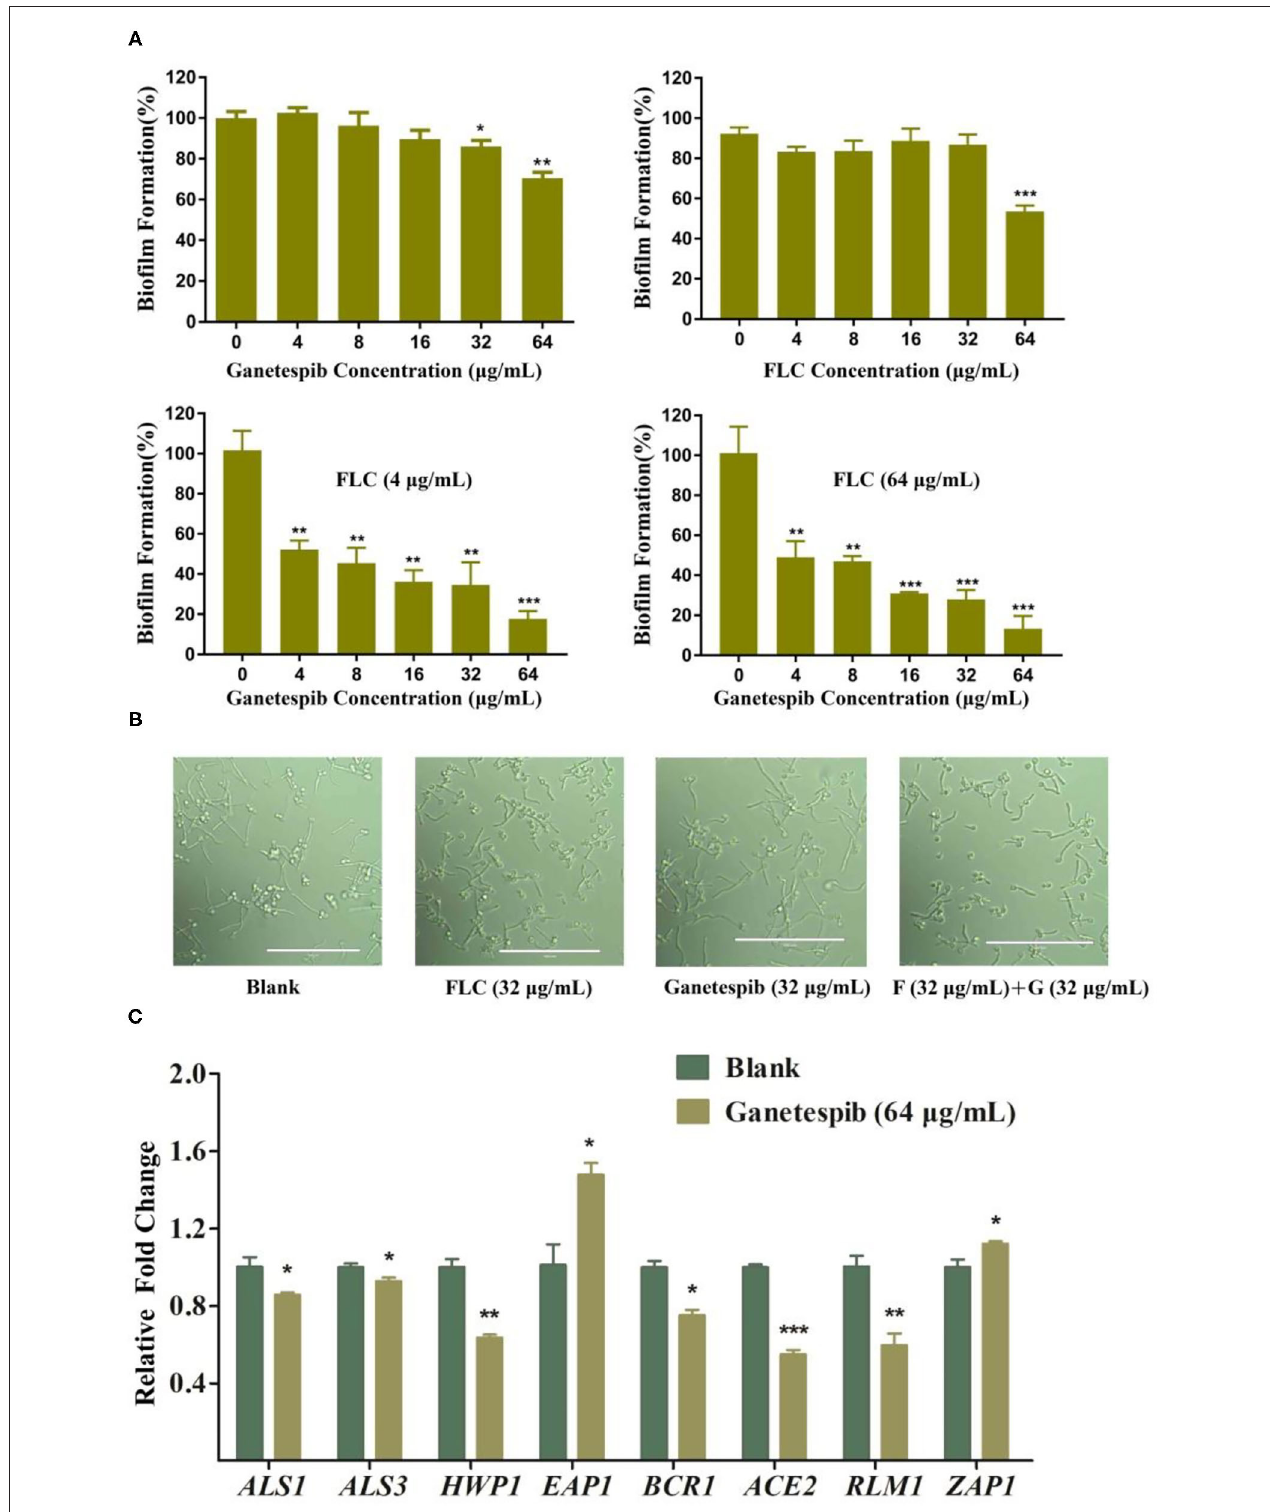
FIGURE 3 | (A) Effect of ganetespib, FLC, or both on the C. albicans 0304103 biofilm formation. (B) Filamentation microscopic observation of C. albicans 0304103 treated with FLC (F), ganetespib (G), or their combination. (C) Expression levels of biofilm formation-related and filamentation genes (* P < 0.05, ** P < 0.01, *** P < 0.001, determined by Student’s t